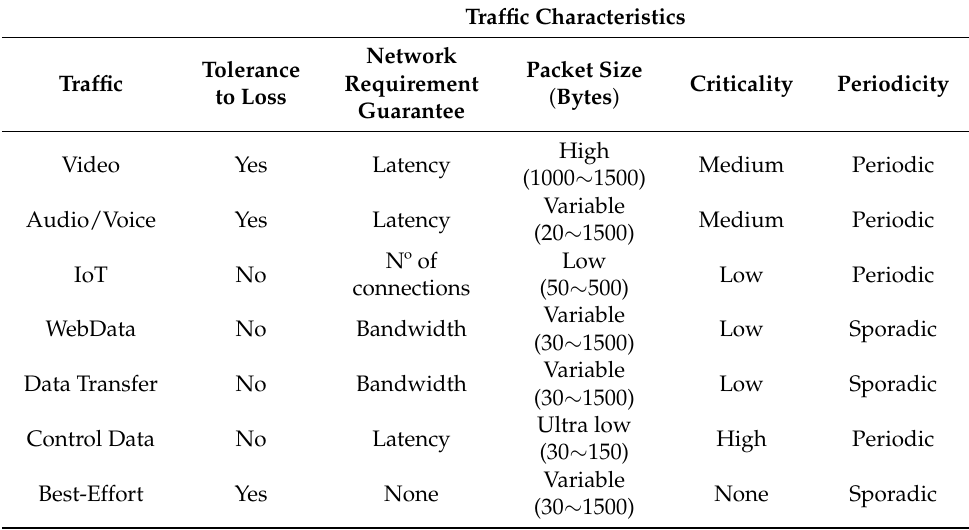
Table 2. Traffic-type characteristics